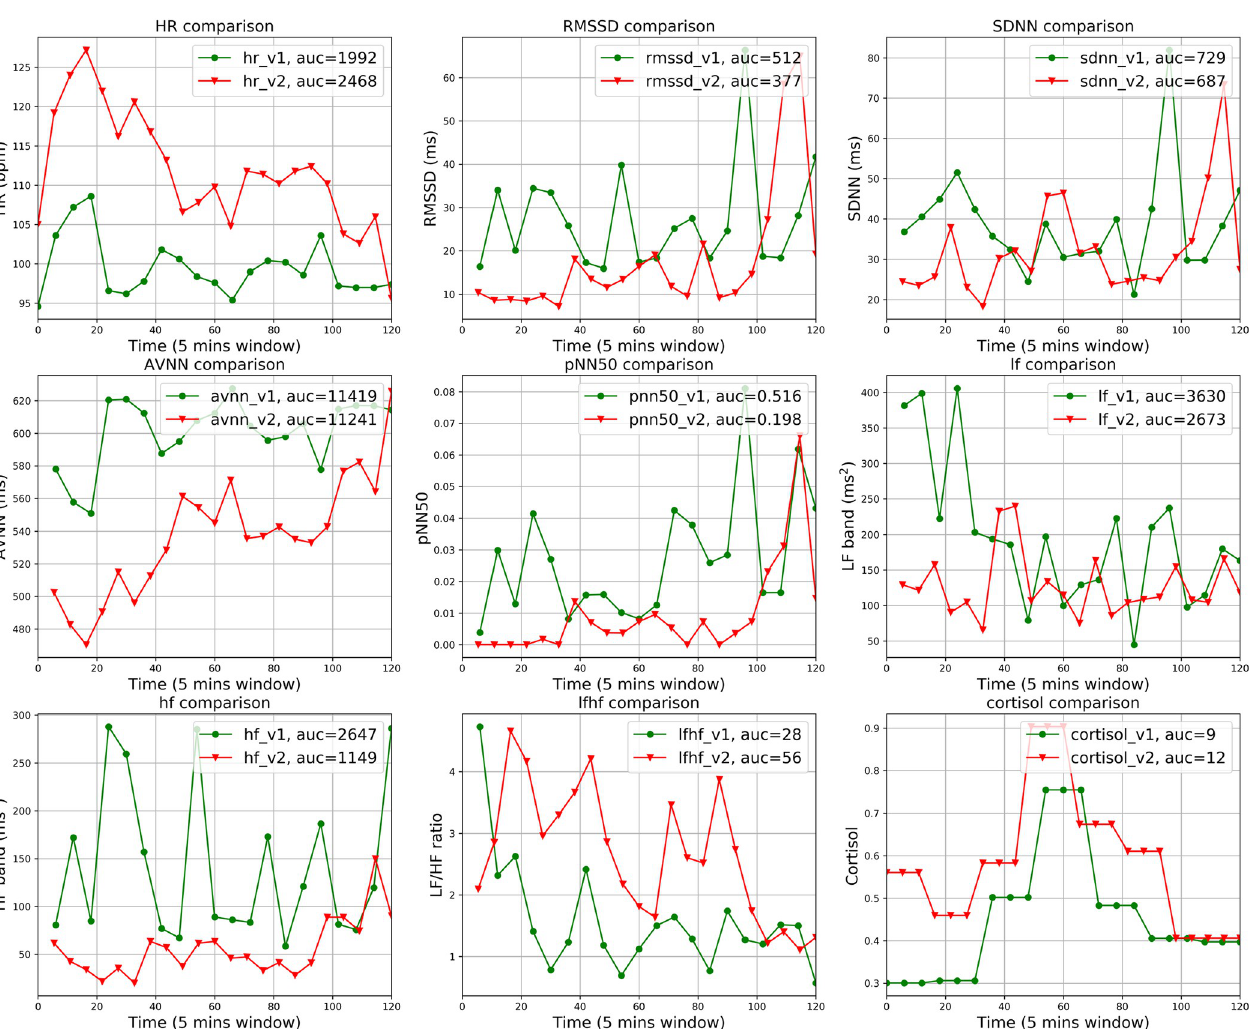
Fig 2. Comparison of the HR, HRV parameters, and cortisol between visit 1 and visit 2 in 5-minute segments for a sample participant. This participant demonstrated an obvious difference in HR, HRV parameters, and cortisol.